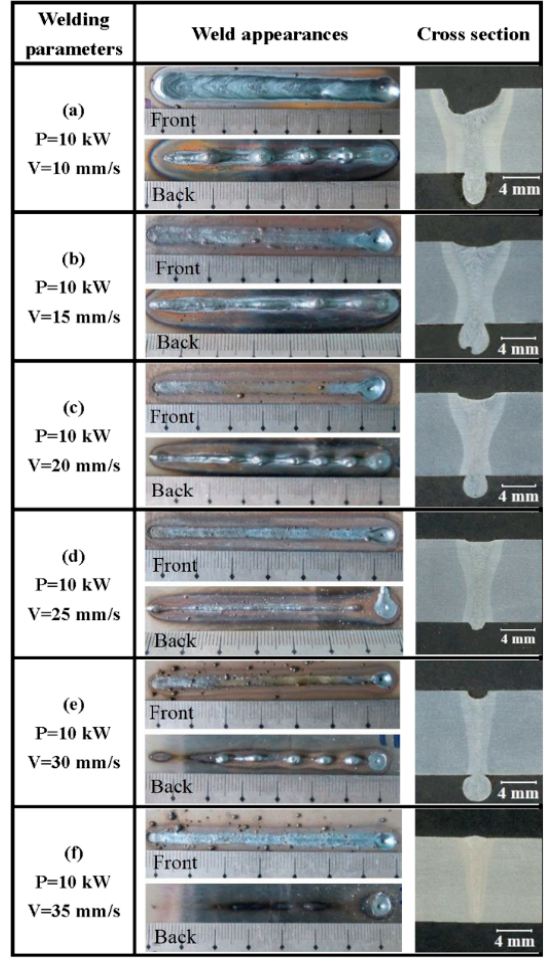
Figure 2. Weld appearances and cross sections of single-pass full-penetration laser-welded high- strength steel at various welding speeds (P—laser power; V—welding speed).